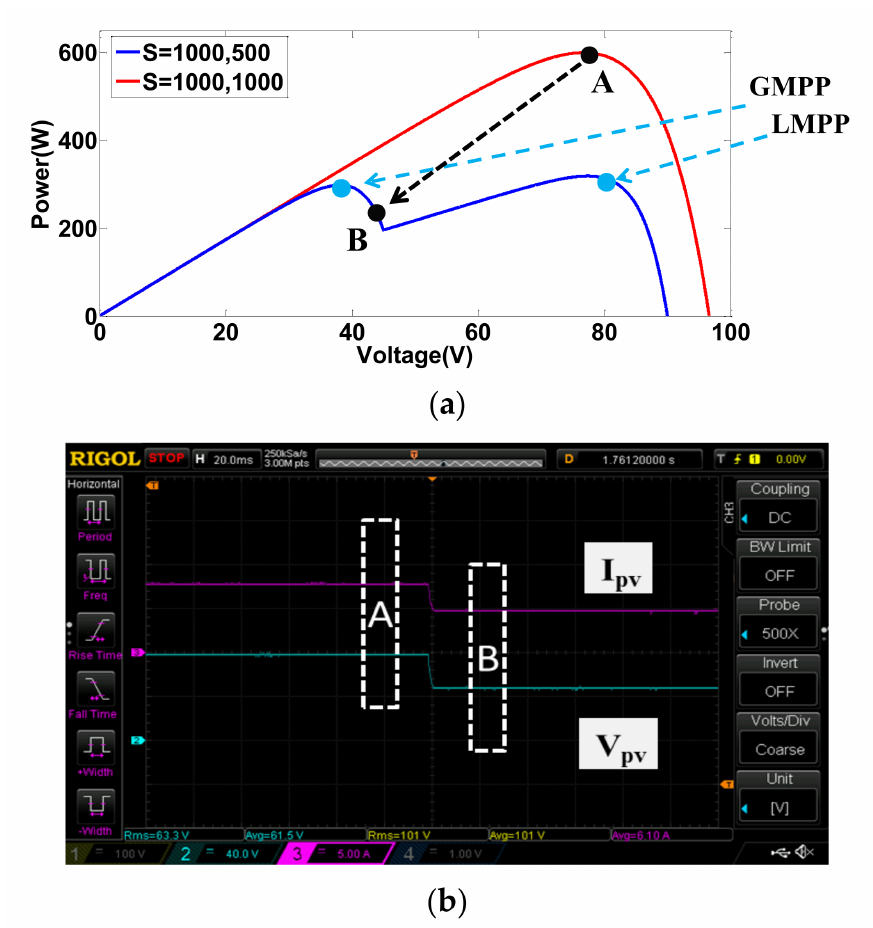
Figure 16. Results of transition from normal condition (A) to shading condition (B): ( a ) simulation; ( b )